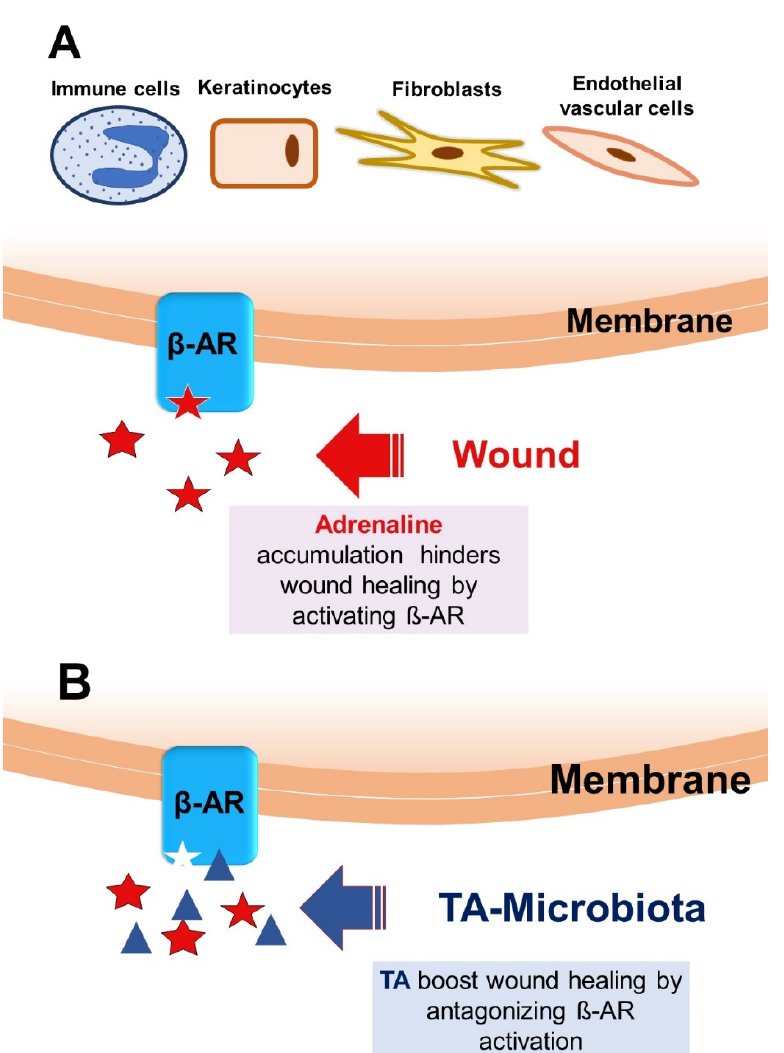
Figure 1. The role of adrenaline and TA in wound healing. ( A ) Cells of the epidermis, dermis, and hypodermis express ß-AR and are therefore responsive to elevated adrenaline levels triggered by wounding as a stress reaction. Sustained ß-AR activation due to elevated adrenaline levels results in a number of sequelae: (a) impairment of the migration ability of keratinocytes and re-epithelization; (b) delay of infiltration of the immune cells to the wound, as well as delay of cytokine production and macrophage recruitment; (c) decrease in collagen production and migration of fibroblasts; (d) inhibition of angiogenesis by endothelial vascular cells. ( B ) TAs, particularly those produced by skin microbiota, antagonize the effect of adrenaline by interacting allosterically with ß2-AR, thus boosting wound closing.